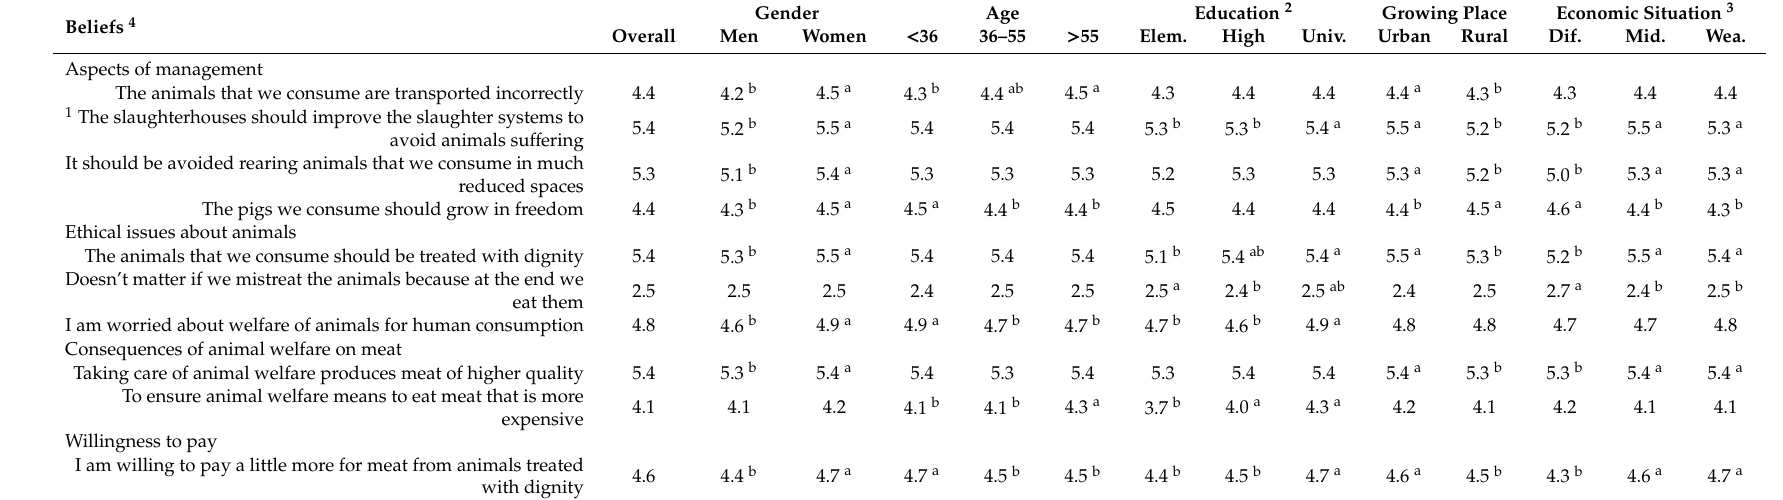
Table 2. The beliefs of Eastern European consumers about animal welfare and the e ff ect of demographics 1 . Gender Growing Beliefs 4